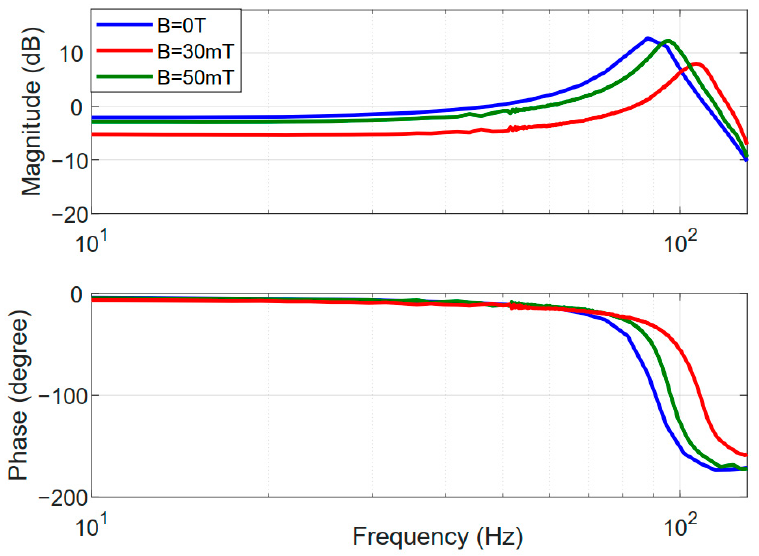
Figure 11. Frequency response of the nanopositioner prototype.